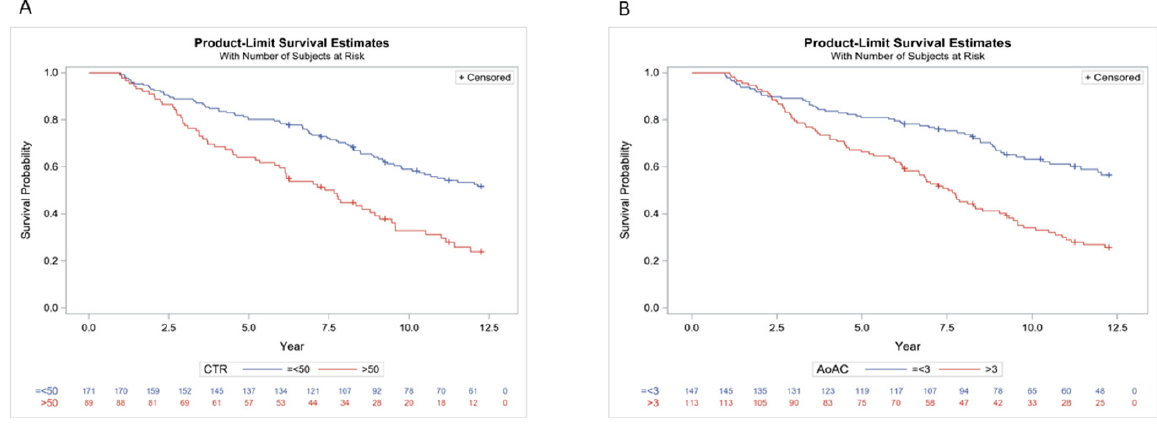
Figure 5. Kaplan–Meier analysis of CV mortality according to ( A ) CTR > 50% or ≤ 50%, and ( B ) AoAC > 3 or ≤ 3 in study patients (all log-rank p < 0.0001). 3.9. Correlation between Δ CTR and Δ AoAC with Overall Mortality Table 8 shows the association between Δ CTR and Δ AoAC with overall mortality. Δ CTR or Δ AoAC are defined as last year CTR or AoAC minus baseline CTR or AoAC over time. After multivariable analysis, Δ CTR (per 1%; OR = 1.13; 95% CI = 1.06 to 1.21; p = 0.0003) was significantly associated with increased overall mortality. However, Δ AoAC (per 1 score; OR = 0.97; 95% CI = 0.88 to 1.08; p = 0.6084) was not. Table 8. Association of Δ CTR and Δ AoAC with overall mortality. Death vs. Non-Death